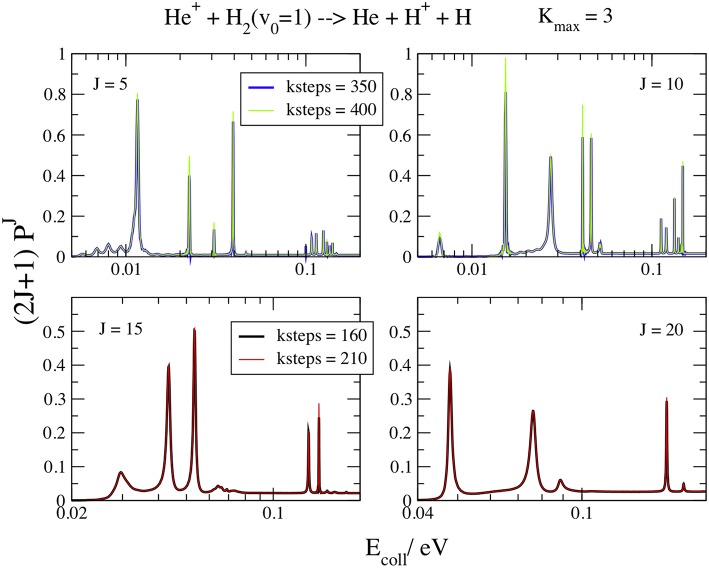
v0 = 1; J = 5, 10, 15, 20; Kmax = 3. Convergence of the opacities (2J+1)Pv0J with respect to kstep.